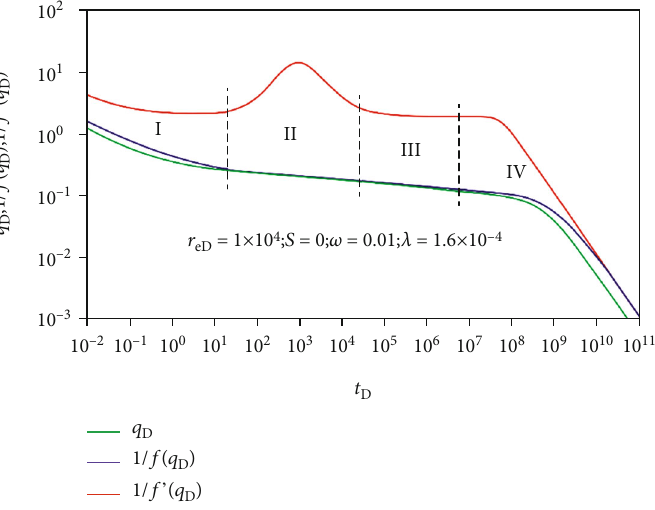
Figure 7: Type curves of rate decline for a dual-porosity